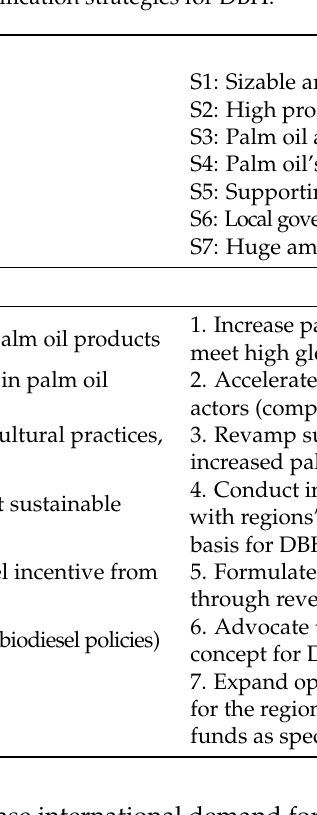
Table 8. Diversification strategies for